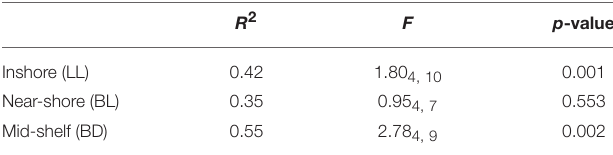
TABLE 2 | PERMANOVA results for the comparison of bacterial communities on OTU level between natural reef surface and artificial ceramic tiles at the three sites. R 2 F p -value